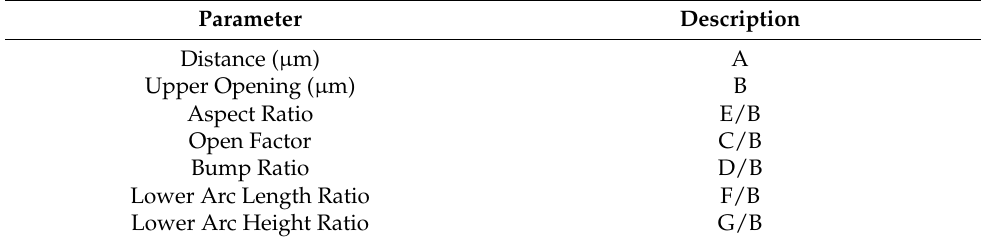
Table 1. Parameters of the microstructure and their